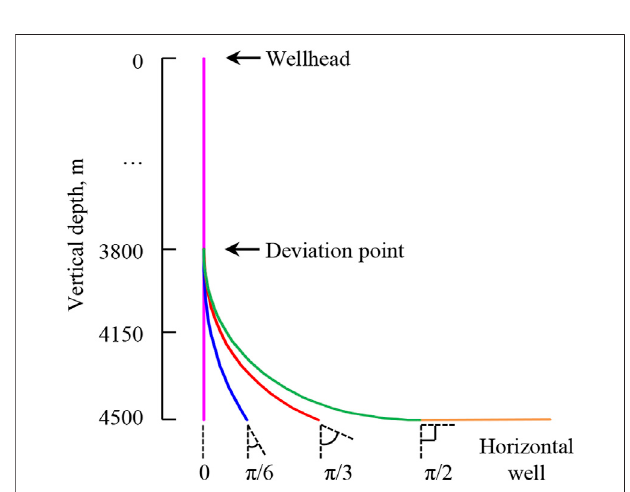
FIGURE 16 | The schematic diagram of wellbore trajectories with different hole deviation